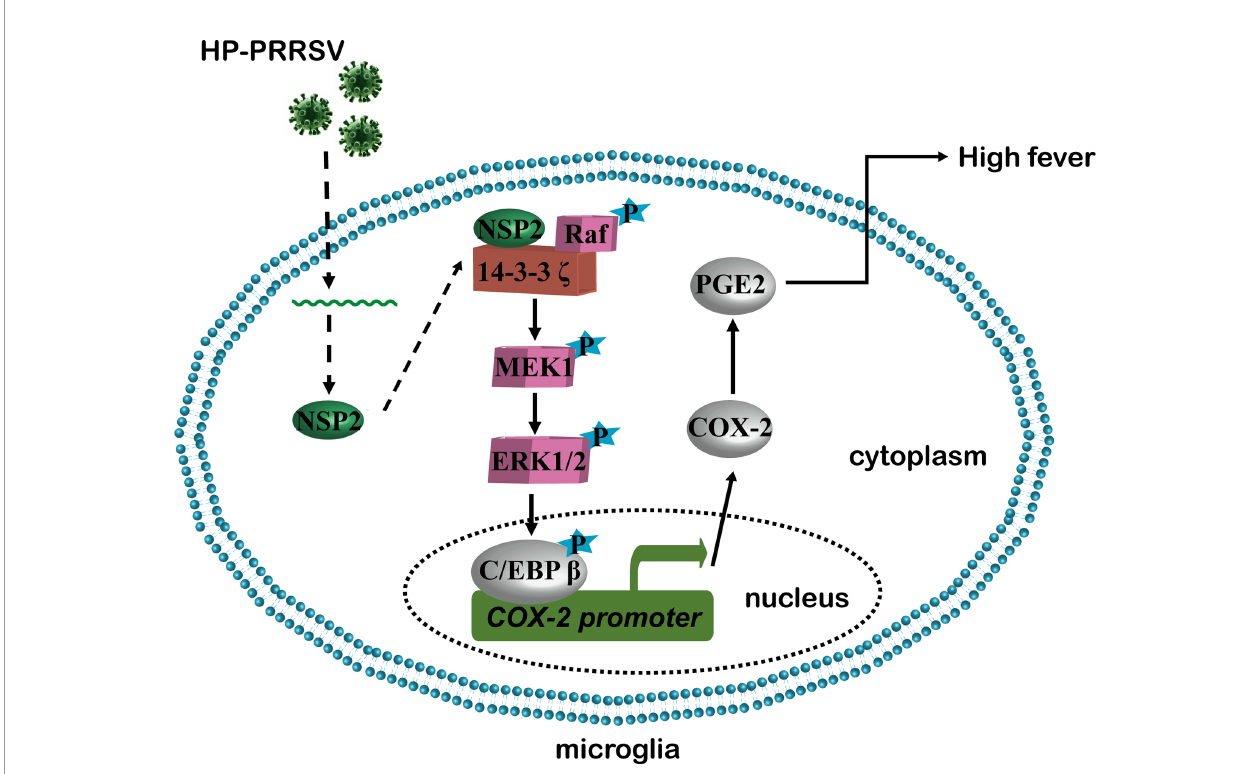
FIGURE 10 | A working model of how HP-PRRSV triggers high